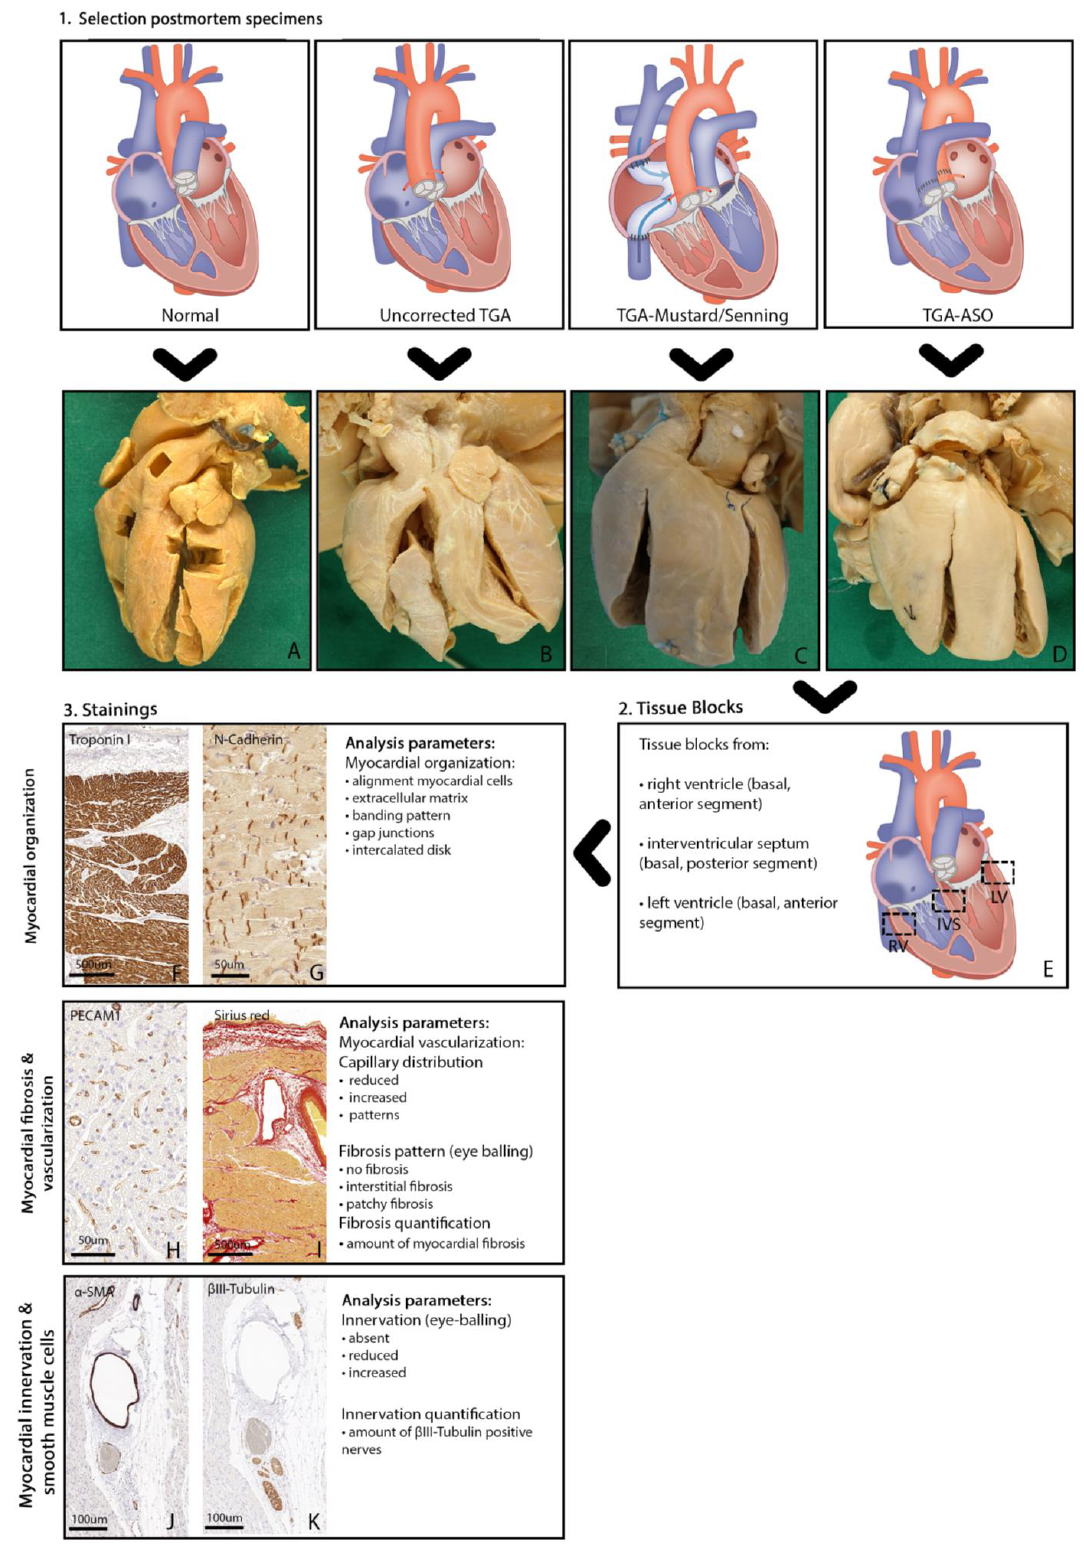
Figure 2. Illustration study design. Study design: illustration of all consecutive steps. 1. Selec- tion postmortem specimens: postmortem specimens were obtained from the Leiden Collection of Congenital Malformations, including the following groups: normal specimens ( A ), uncorrected